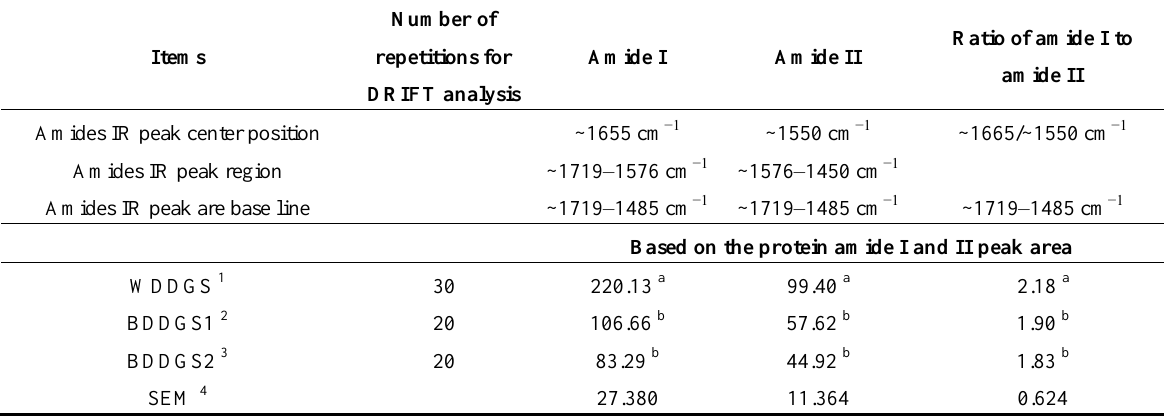
Table 1. Amide I and II and their ratios: Comparison of wheat DDGS and two types of blend DDGS using DRIFT molecular spectroscopy.